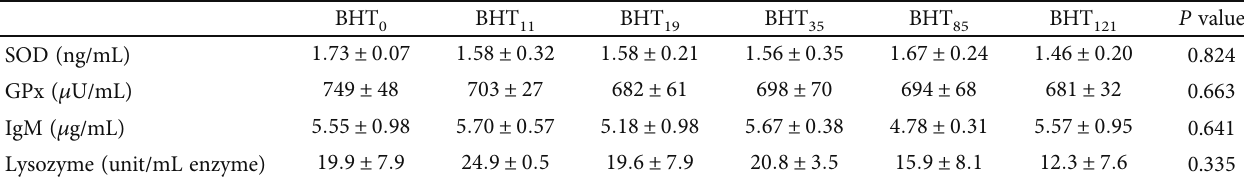
Table 3: Nonspeci fi c immune responses of olive fl ounder ( Paralichthys olivaceus ) fed experimental diets for 120 days 1 .